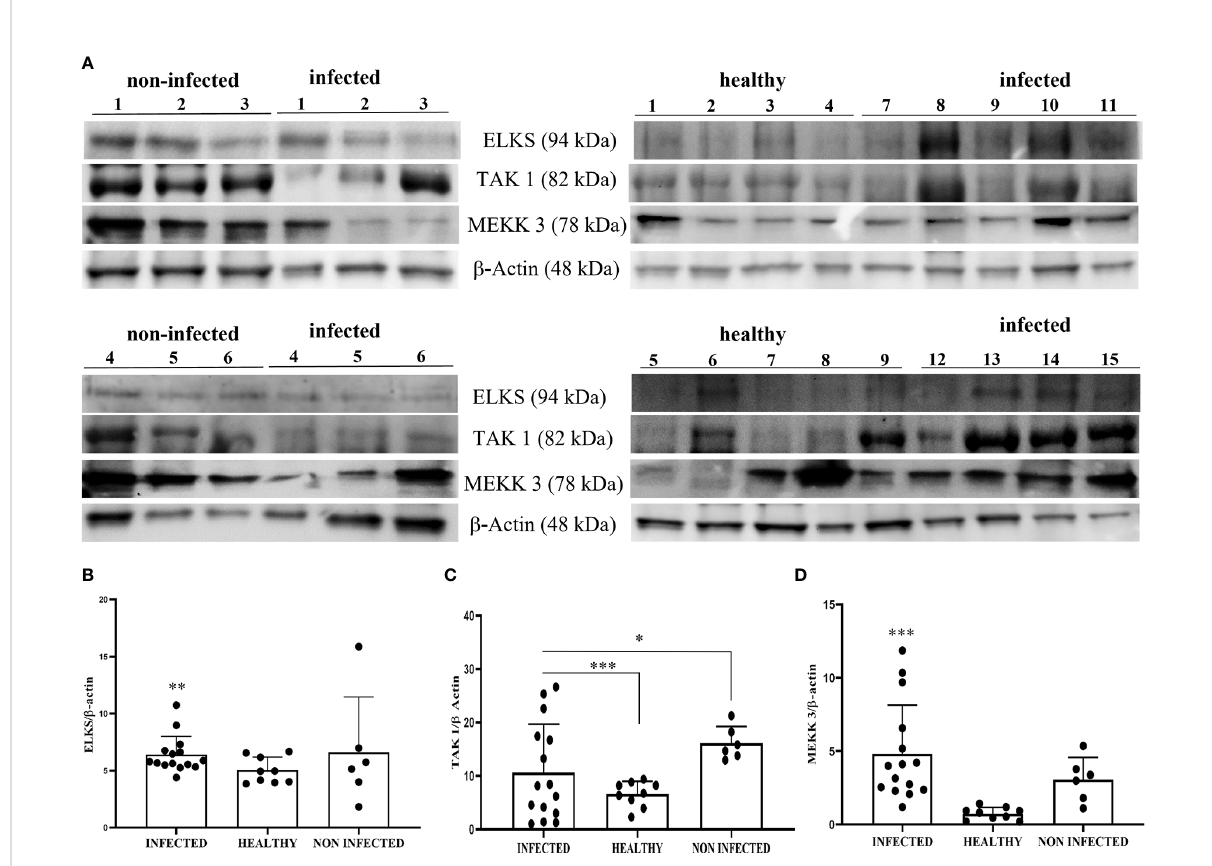
FIGURE 12 (A) Western blot analysis of ELKS, TAK1, and MEKK3 proteins in infected, non-infected, and healthy bladder samples. Densitometric analysis of ELKS (B) , TAK1 (C) , and MEKK3 (D) protein levels relative to b -actin protein levels. Each protein exhibited a signi fi cant increase in infected bladder samples compared with both non-infected and healthy samples (*p ≤ 0.05; **p ≤ 0.01; ***p ≤ 0.001). Plots present values found for each sample performed in